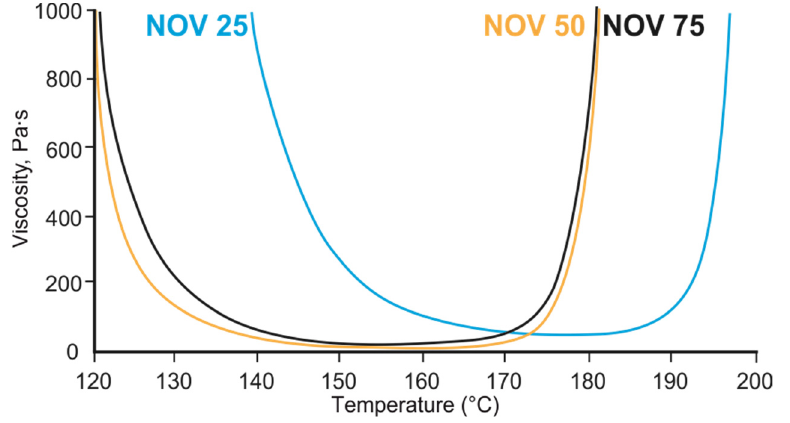
Figure 5. Viscosity – temperature profiles of blends NOV 25, NOV 50, NOV 75. Figure 5. Viscosity–temperature profiles of blends NOV 25, NOV 50, NOV